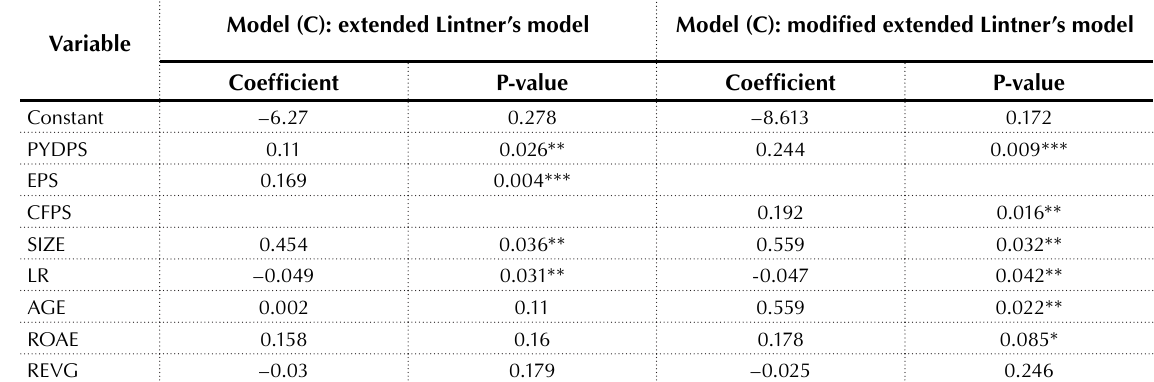
Table 13. Results of model (C) – logit regression